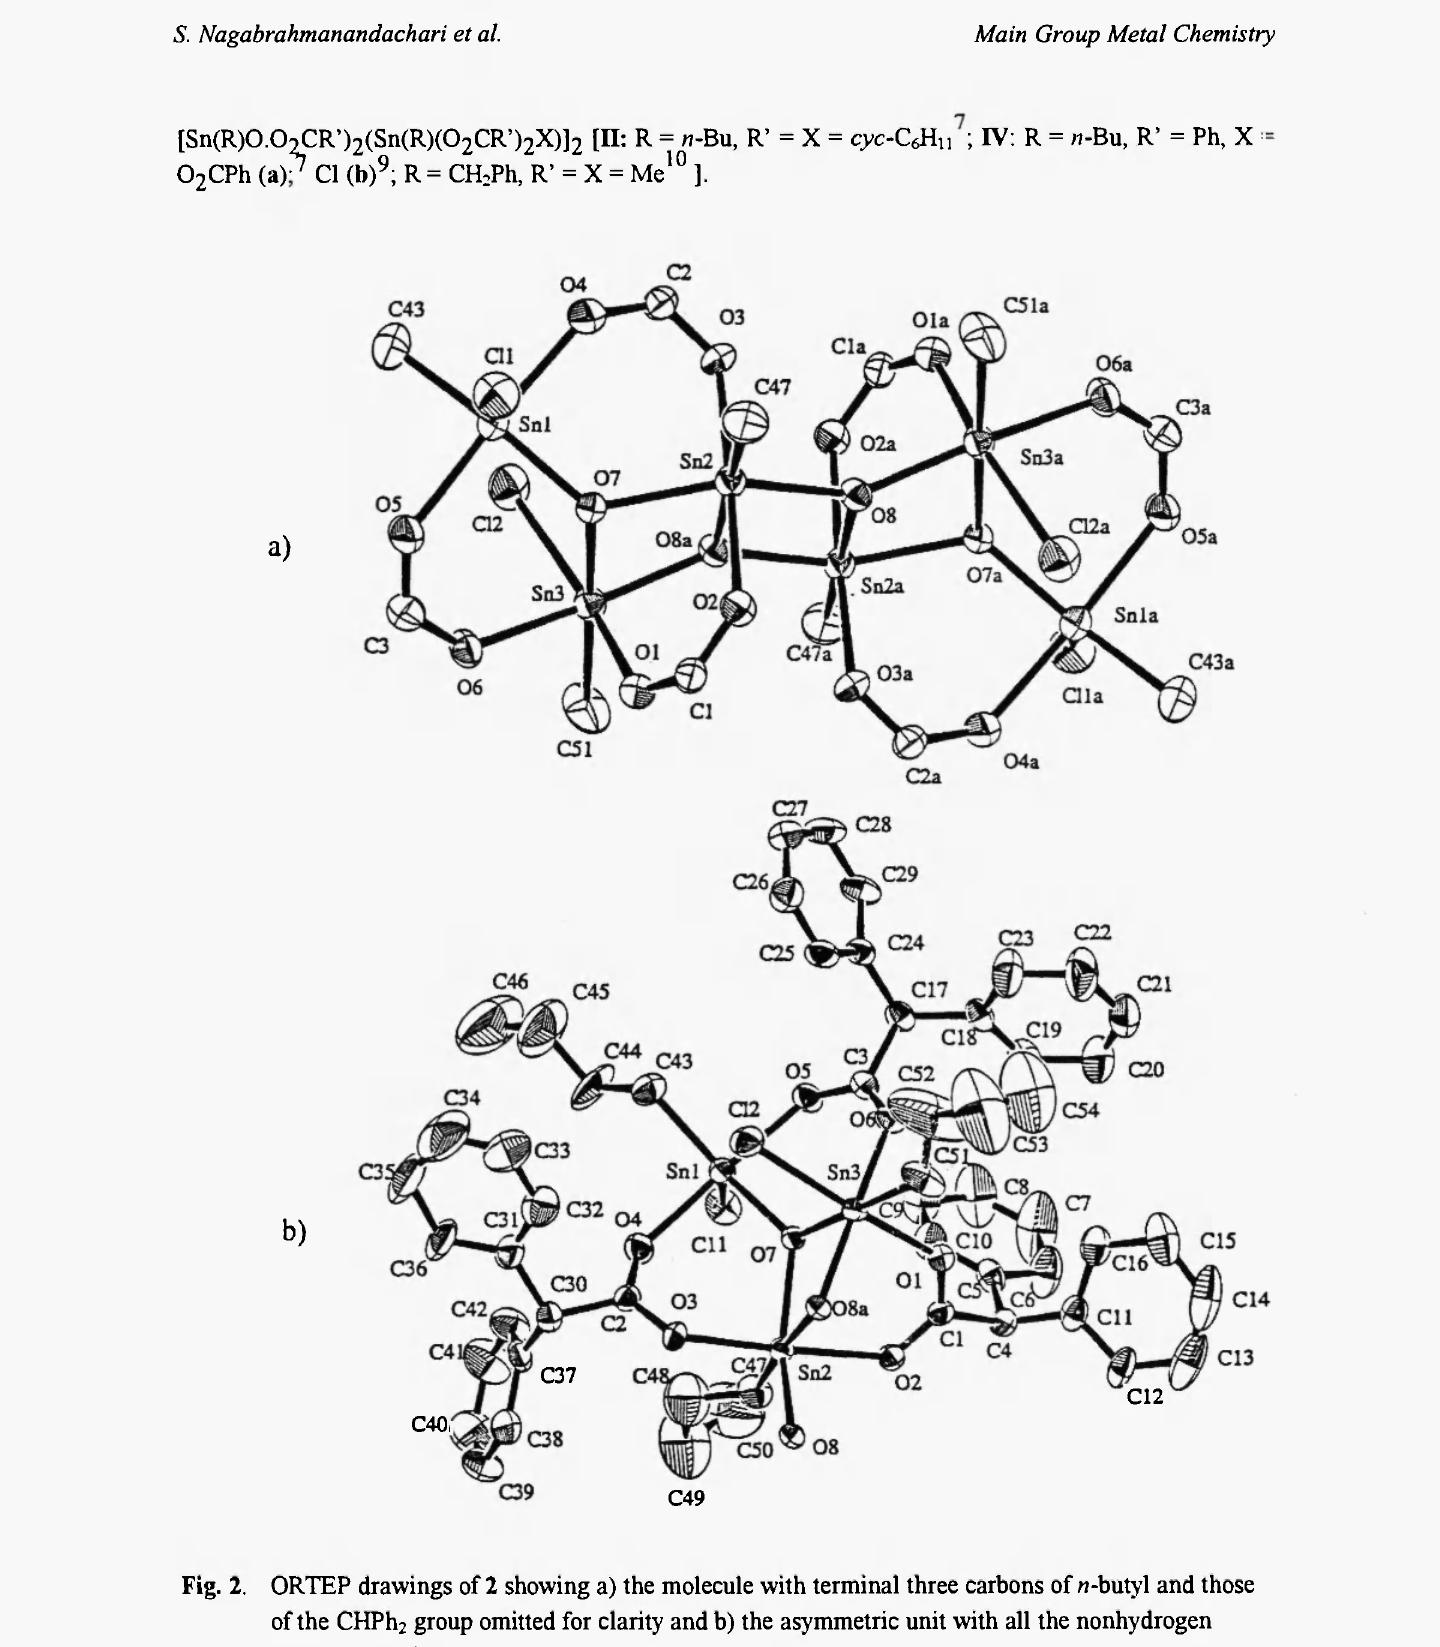
Fig. 2. ORTEP drawings of 2 showing a) the molecule with terminal three carbons of «-butyl and those of the CHPh 2 group omitted for clarity and b) the asymmetric unit with all the nonhydrogen atoms